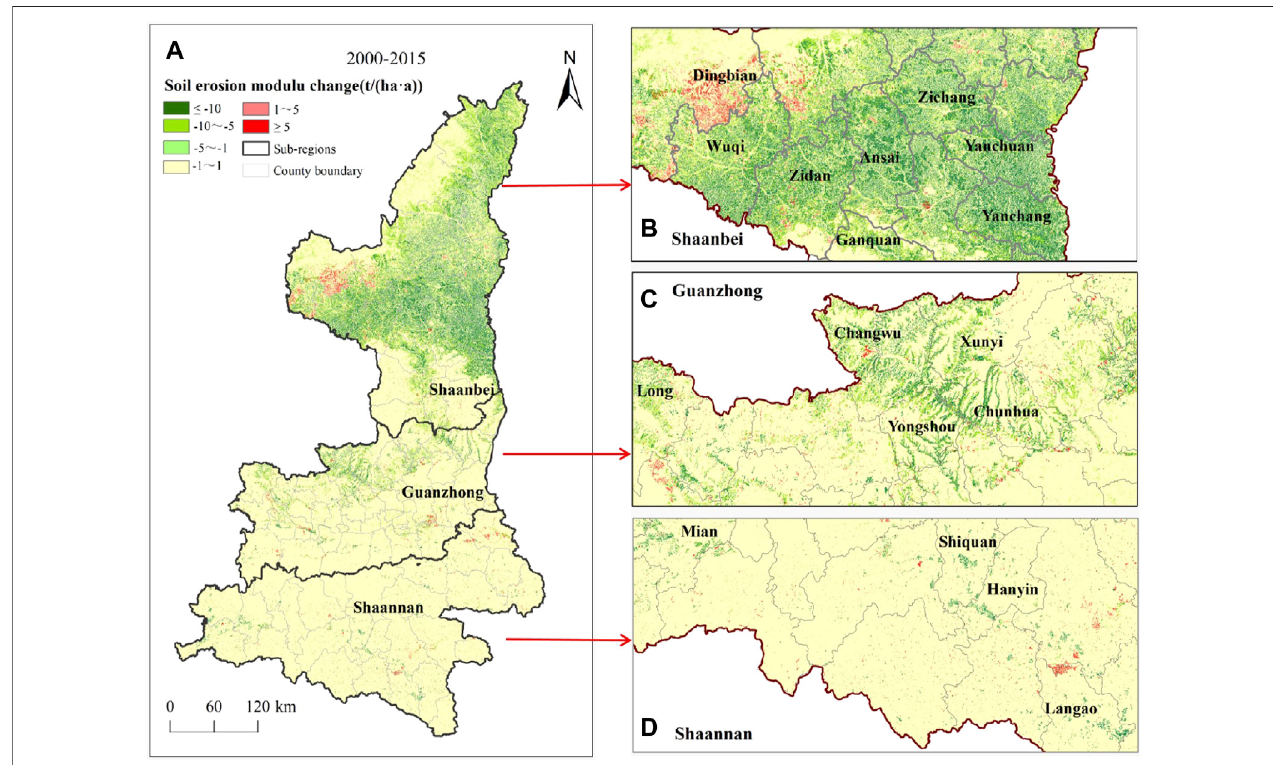
FIGURE 4 | Spatial pattern of changes in soil erosion in Shaanxi: 2000 –